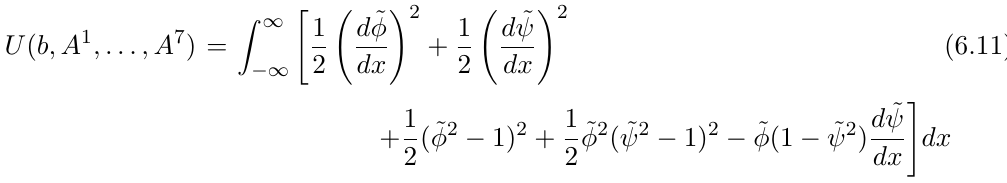
Figure 12 . The dependence of the couplings I ii on the modulus b . Dashed vertical line denotes the positions of the spectral wall related to the i -th mode where the pertinent integral I Here i = 7 , 6 , 5 , 4 which corresponds to the brown, purple, red and green modes respectively. Note that the red mode ( i = 5 ) leads to three singularities as it is expected from the previously found spectral structure, see figure